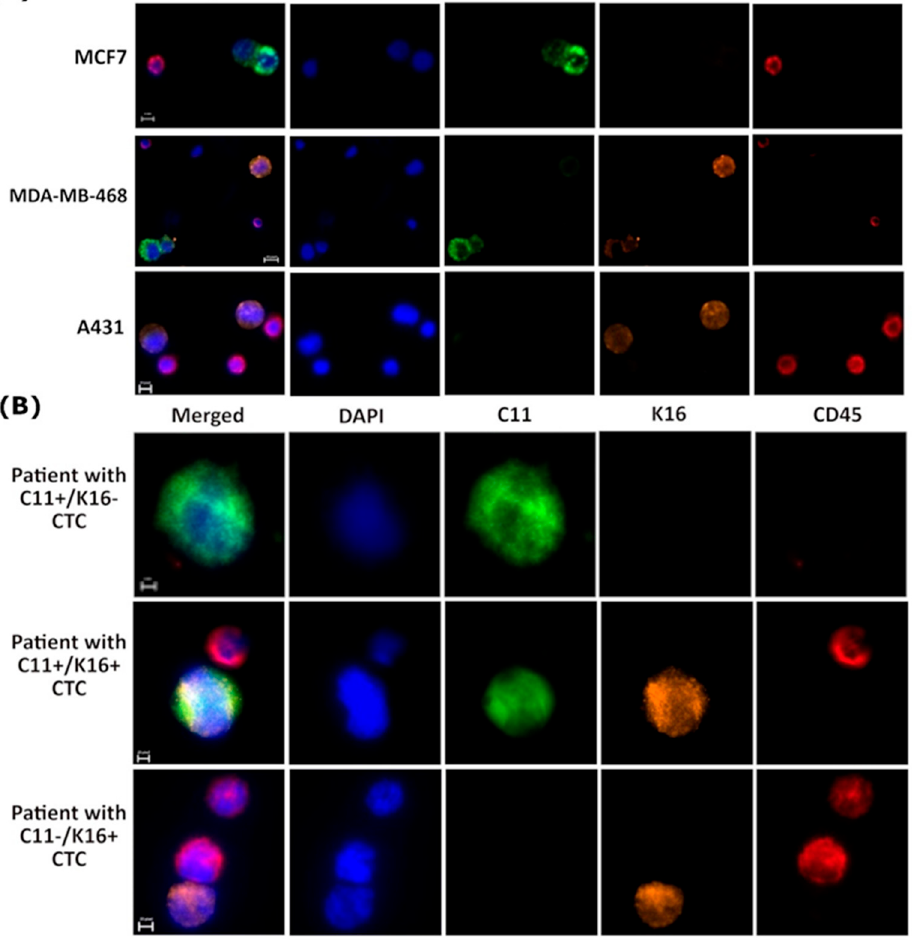
Figure 5. K16 immunocytochemistry staining ( A ) Establishment K16 immunocytochemistry staining; cells were stained by DAPI (blue), CD45 (AF647; red), C11 (AF488; green), and K16 (AF546; orange); scale bar represents 10 µm. ( B ) Detection of CTCs in metastatic breast cancer patients (n = 20); CTCs cells (DAPI+, C11+, K16+, and CD45 − ) were differentiable from the WBCs (DAPI+ and CD45 − ); scale bar represents 10 µm.